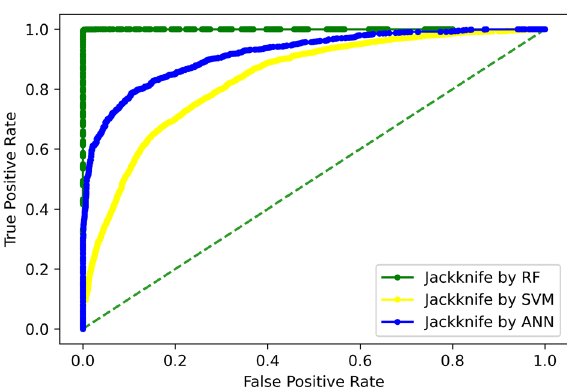
Figure 7. Jack-Knife comparison of ROC curves.